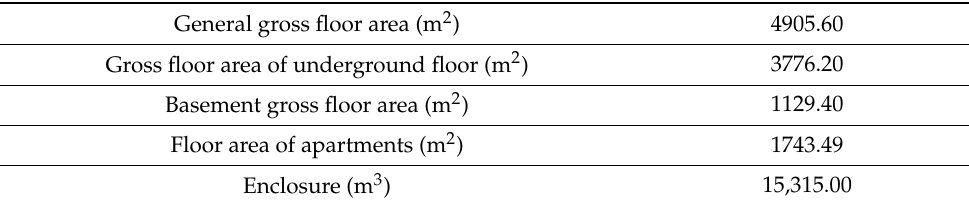
Table 4. Building area and bay